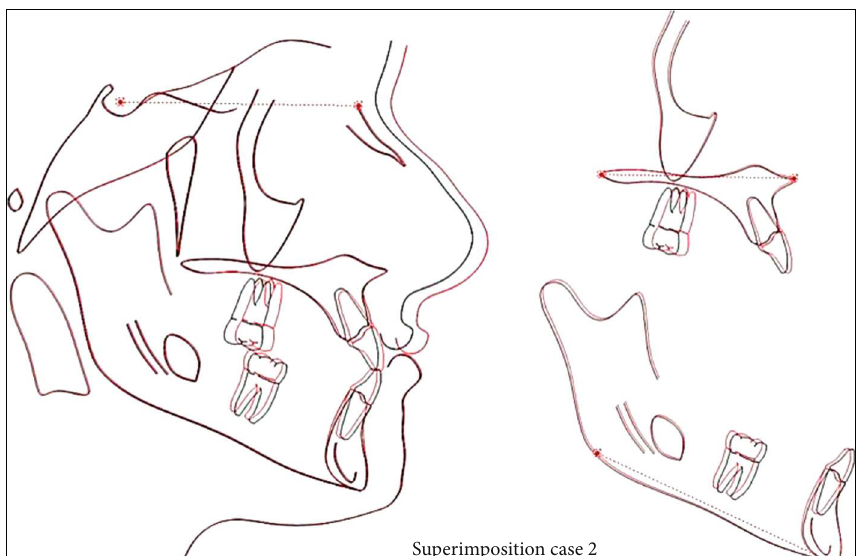
Figure 14: Superimposition.